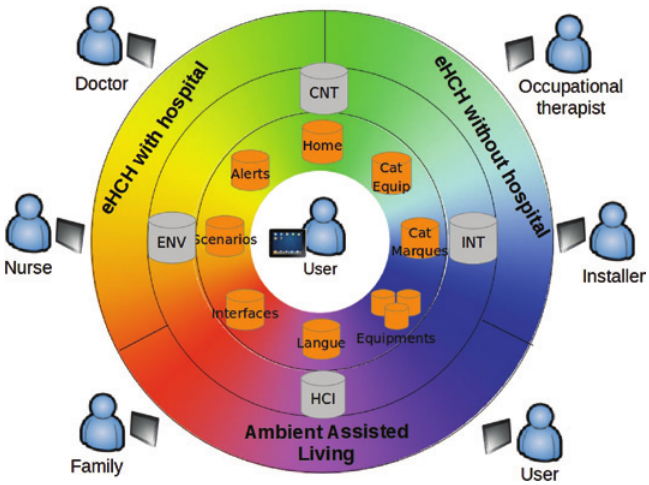
Figure 1: Multiexpert Collaboration to Generate the Final User